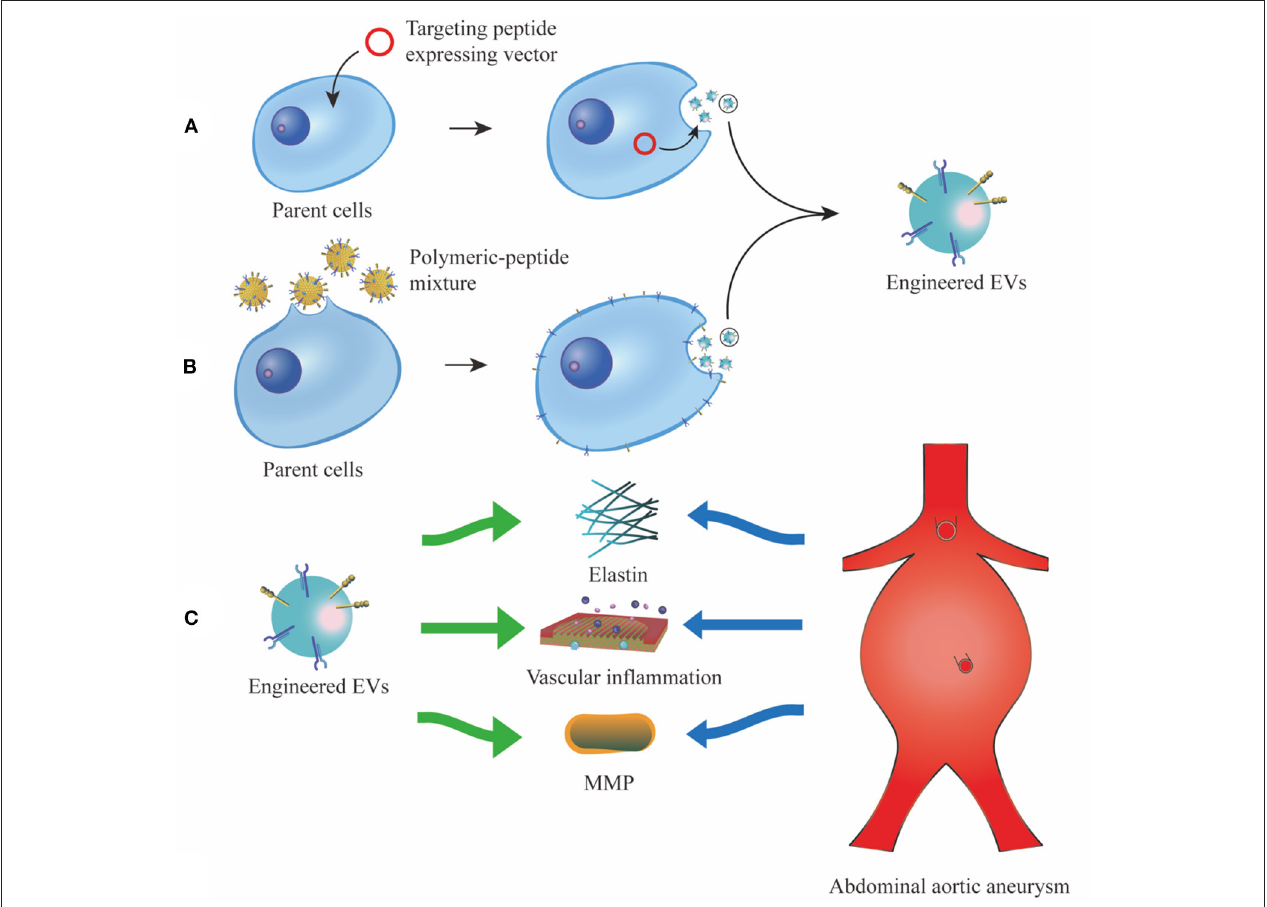
FIGURE 2 | Different strategies of EV display technology. (A) , vectors which convey fusion genes of targeting peptides and EV membrane proteins are transfected into the parent cells. The targeting peptides are overexpressed and enriched on the surface of EV membrane. (B) , targeting peptides are first cocultured with polymeric material, then the polymeric-peptide mixture self-assembles to the membrane of parent cells and their derived EVs. (C) , the engineered EVs can specifically target characteristic tissue and cells in AAA, such as elastin, vascular inflammation and MMP. EV, extracellular vesicle; MMP, matrix